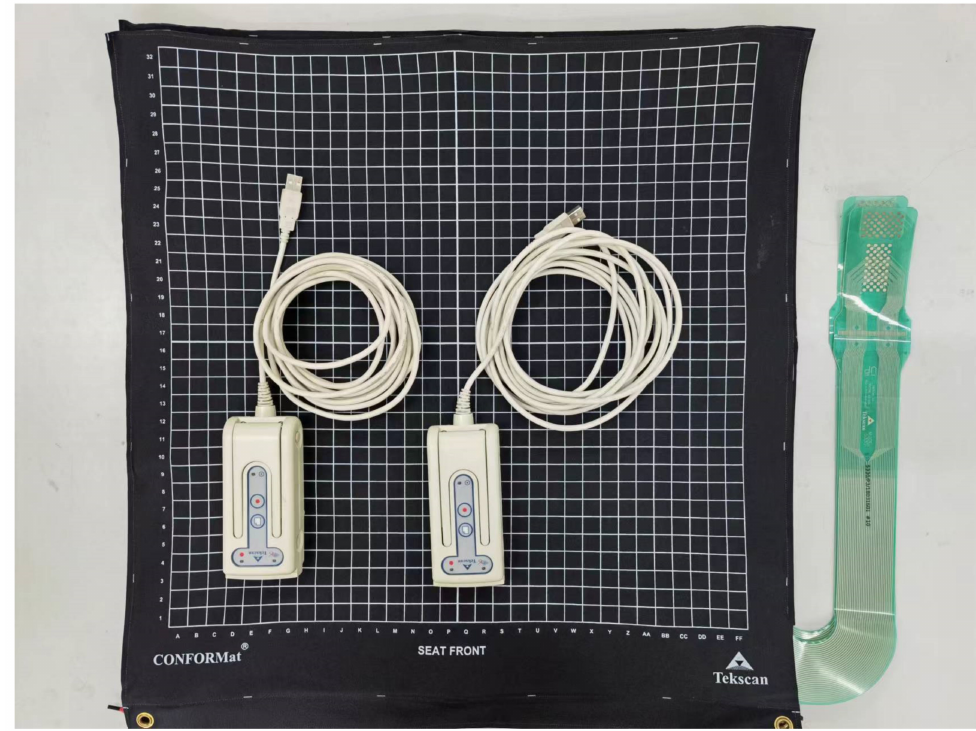
Figure 2. Body pressure distribution measurement